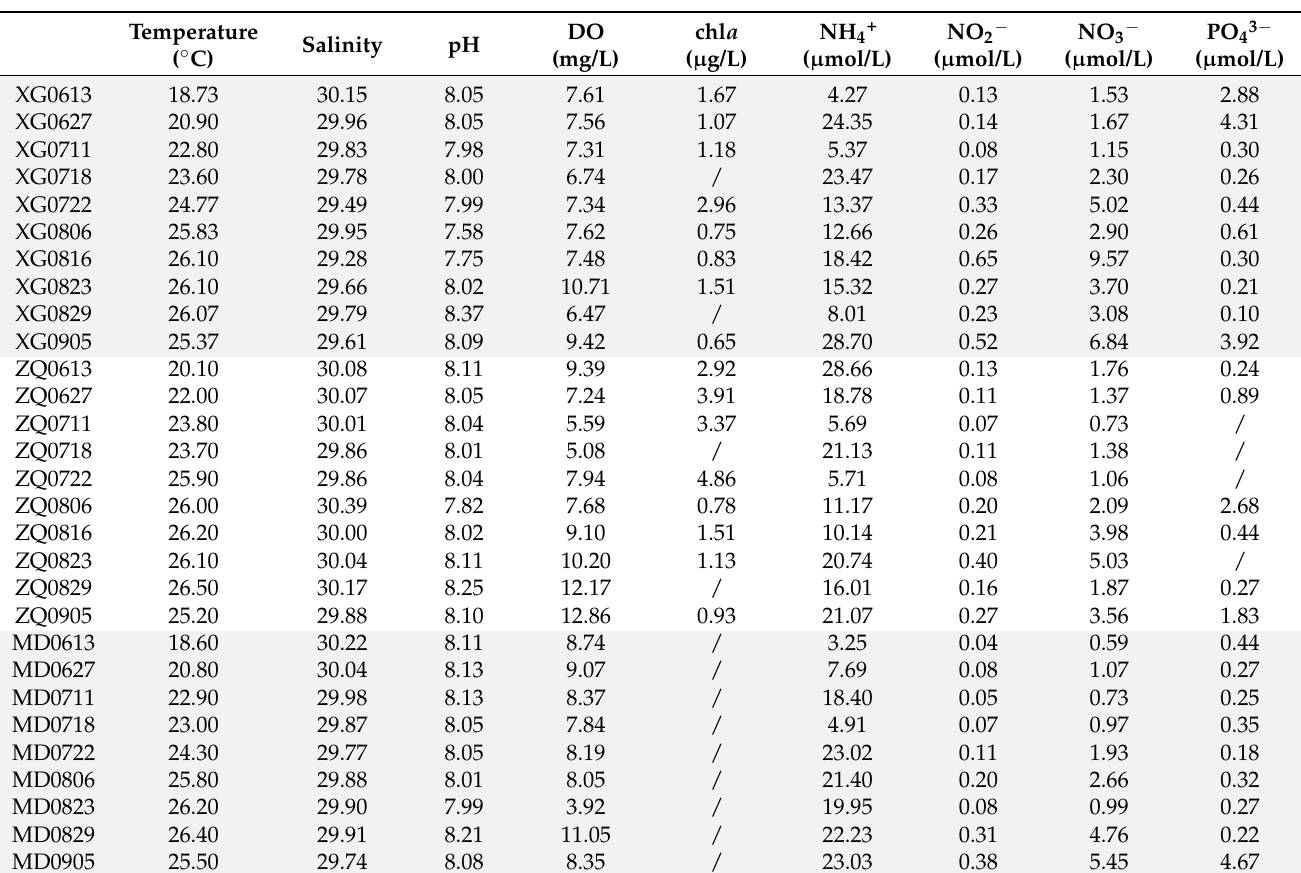
Table 2. Environmental factors in coastal Qingdao areas during the green